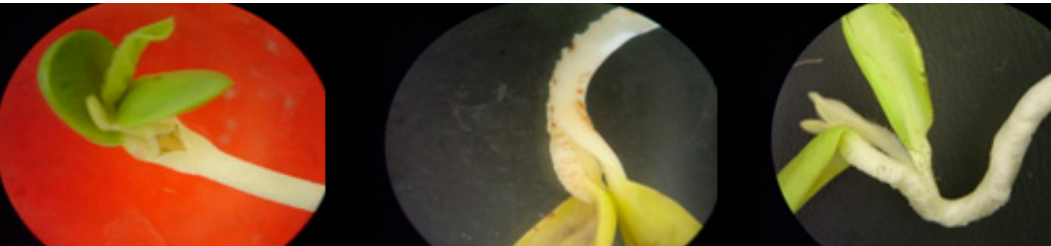
Figure 5. Soybean seedlings from seeds irradiated with UV-B and UV-C (observed in stereoscope at 10X magnification).